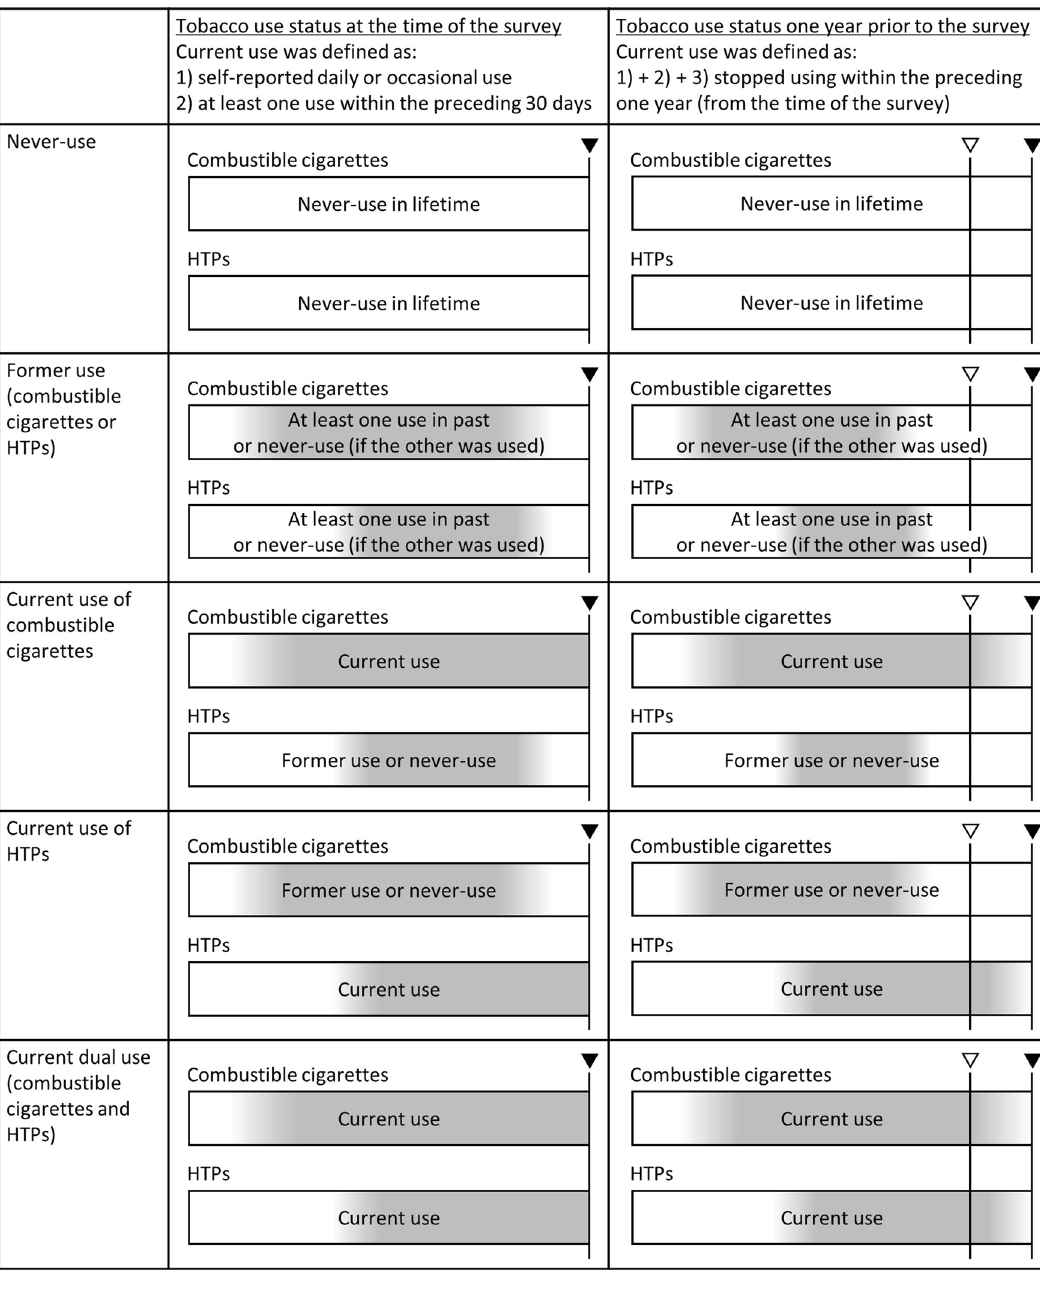
Figure 2. Definition of tobacco use status. Horizontal bars indicate the time course, and gray color indicates the duration of each tobacco use. Inverted triangles indicate the time of the survey ( ▼ ) and one year prior to the survey ( ▽ ). HTPs heated tobacco